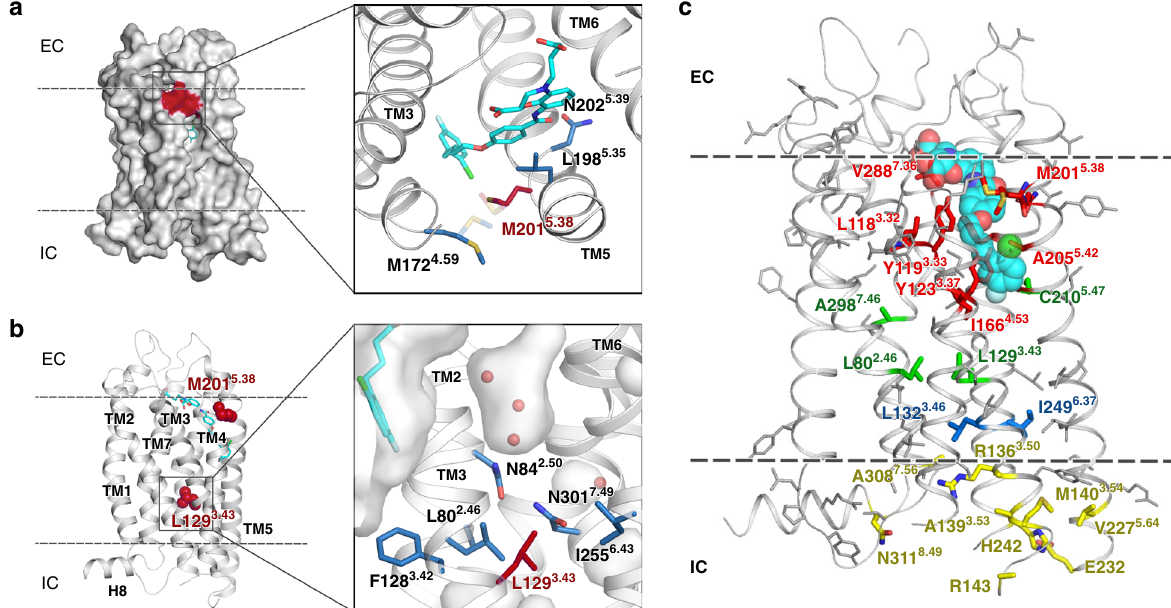
Fig. 4 Naturally occurring missense SNVs, mapped on the CysLT 2 R structure. a M201 5.38 V polymorphism, associated with atopic asthma. b L129 3.43 Q mutation, related to uveal melanoma and blue nevi. c SNVs from the ExAC database and L129 3.43 , colored according to their location: ligand-binding pocket (red), microswitches (blue), sodium site (green), and G protein and β -arrestin-binding interface